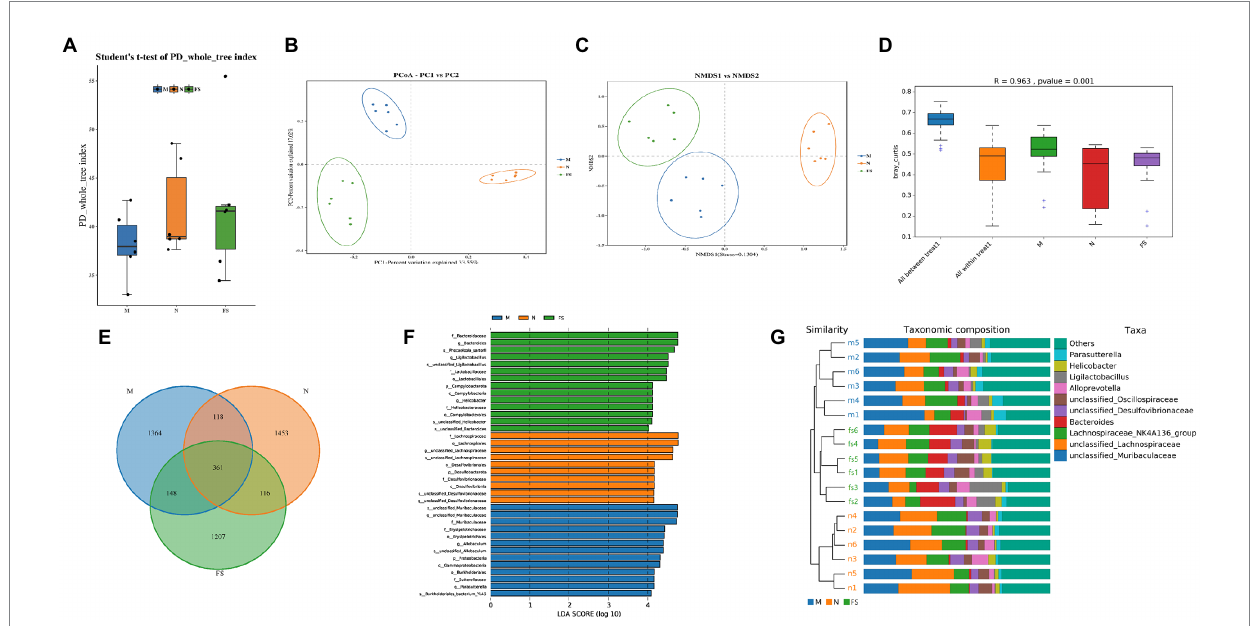
FIGURE 6 The structure of the three groups of bacteria is different. (A) PD whole tree in α -diversity; (B) principal coordinate analysis (pCoA) in β -diversity; (C) non-metric multiscale analysis (NMDS) in β -diversity; (D) anosim analysis; (E) Venn diagrams to compare the sequences of the three groups of bacteria; (F) histogram of LDA value distribution. The ordinate represents the taxonomic units with significant differences between groups, and the abscess represents the logarithmic score values of LDA analysis of each taxonomic unit in a bar chart. The taxon is sorted according to the size of the score value. The longer the length, the more significant the difference between the taxon is. The color of the bar graph indicates the sample group corresponding to the taxon with higher abundance; (G) phylogenetic tree and bar diagram to distinguish the three